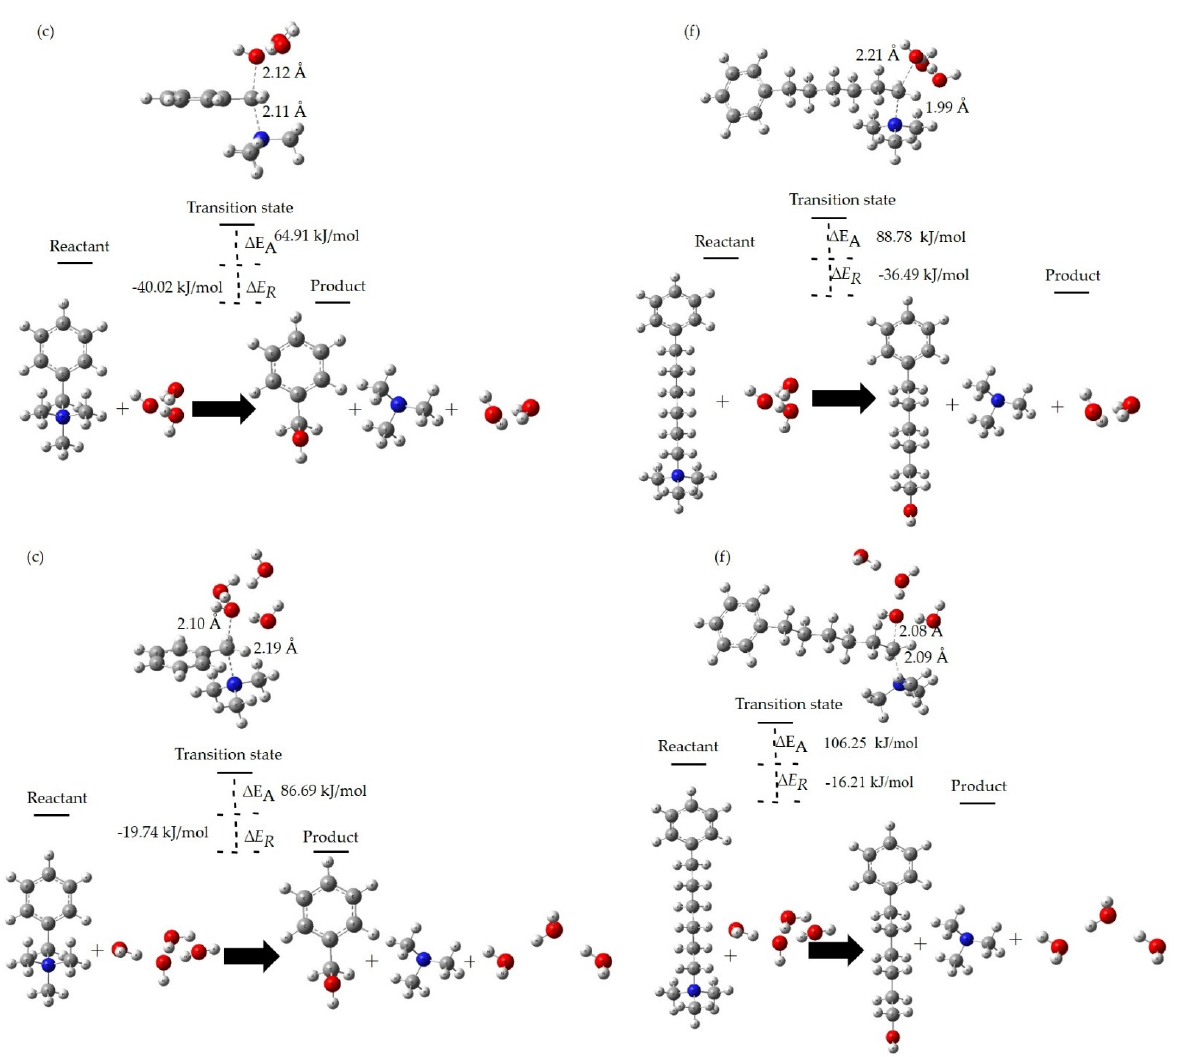
Figure 6. S N 2 degradation reactions for QA head groups, BTMA ( c ) and TMHA ( f ), at the different HLs.